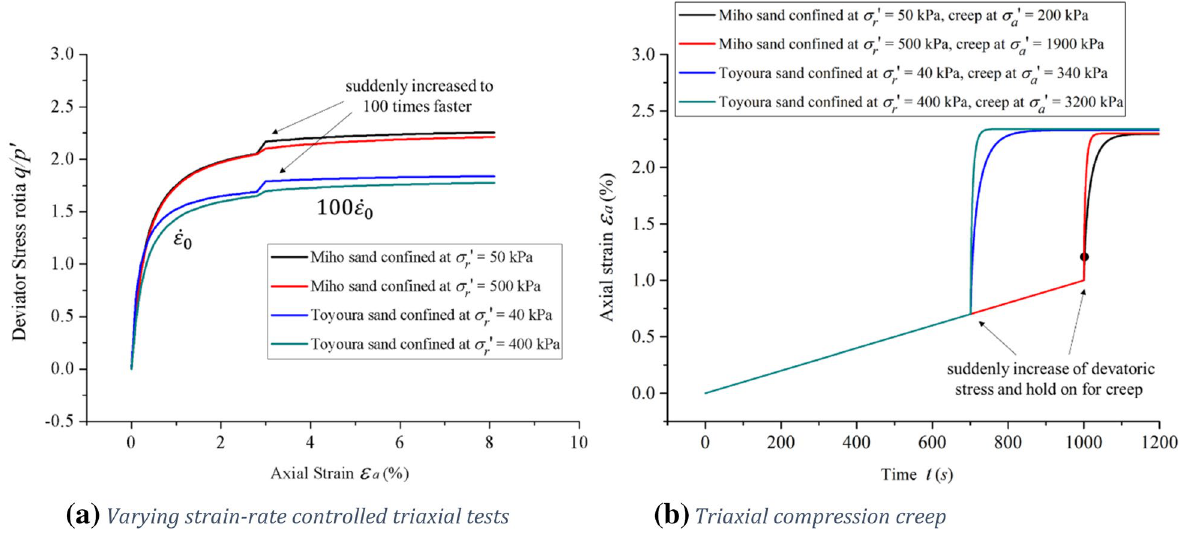
Figure 7. The influence of effective isotropic stresses on the viscosity type of rate-dependent behavior of sands. Red and green lines represent weak Isotach or TESRA behavior, whilst blue and black lines represent strong Isotach